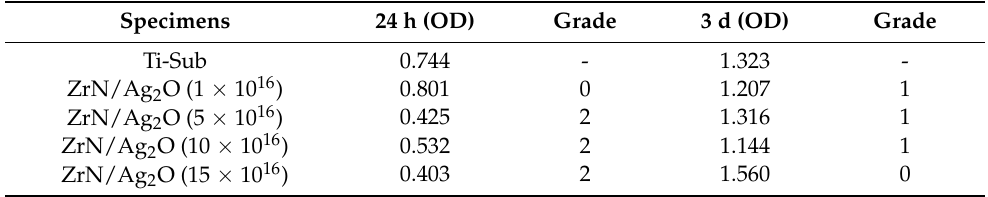
Figure 11. ( a ) Antibacterial ratios of the re-cultivated S. aureus and E. coli colonies on agar for different doses of ZrN/Ag 2 O gradient composite coatings; ( b ) the release concentration of silver ions for different doses of ZrN/Ag 2 O coatings in Ringer’s solution after 30 days. Table 3. The absorbance at wavelengths of 450 nm and the toxicity grade of ZrN/Ag 2 O gradient composite coatings.